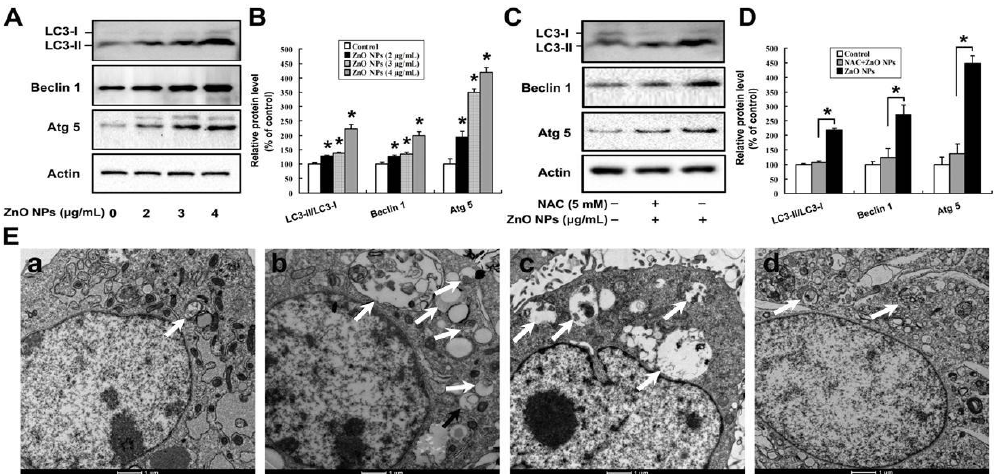
Figure 5. Oxidative stress is involved in ZnO NPs-induced autophagy of mouse Leydig TM3 cells. Mouse Leydig TM3 cells were treated with 0–4 µ g / mL ZnO NPs for 24 h ( A ) or treated with 4 µ g / mL ZnO NPs for 24 h in absence or presence of 5 mM NAC ( C ); then, the protein levels of LC 3, Atg 5, and Beclin 1 were quantified by Western blot. ( B,D ) The relative protein levels of LC 3, Atg 5, and Beclin 1 were quantified by densitometry. ( E ) The cells were treated with ddH 2 O, bars: 1 µ m, ( a ), 4 µ g / mL ZnO NPs ( b ), or 5 mM N-acetyl-L-cysteine (NAC) plus 4 µ g / mL ZnO NPs for 24 h ( d ). Then, autophagic vacuoles in the cells were visualized by transmission electron microscopy (TEM), with starvation-treated cells as a positive control ( c ). The autophagic vacuoles are indicated by white arrows. The experiment was done in triplicate and repeated three times. Data were analyzed by one-way ANOVA. * p < 0.05.